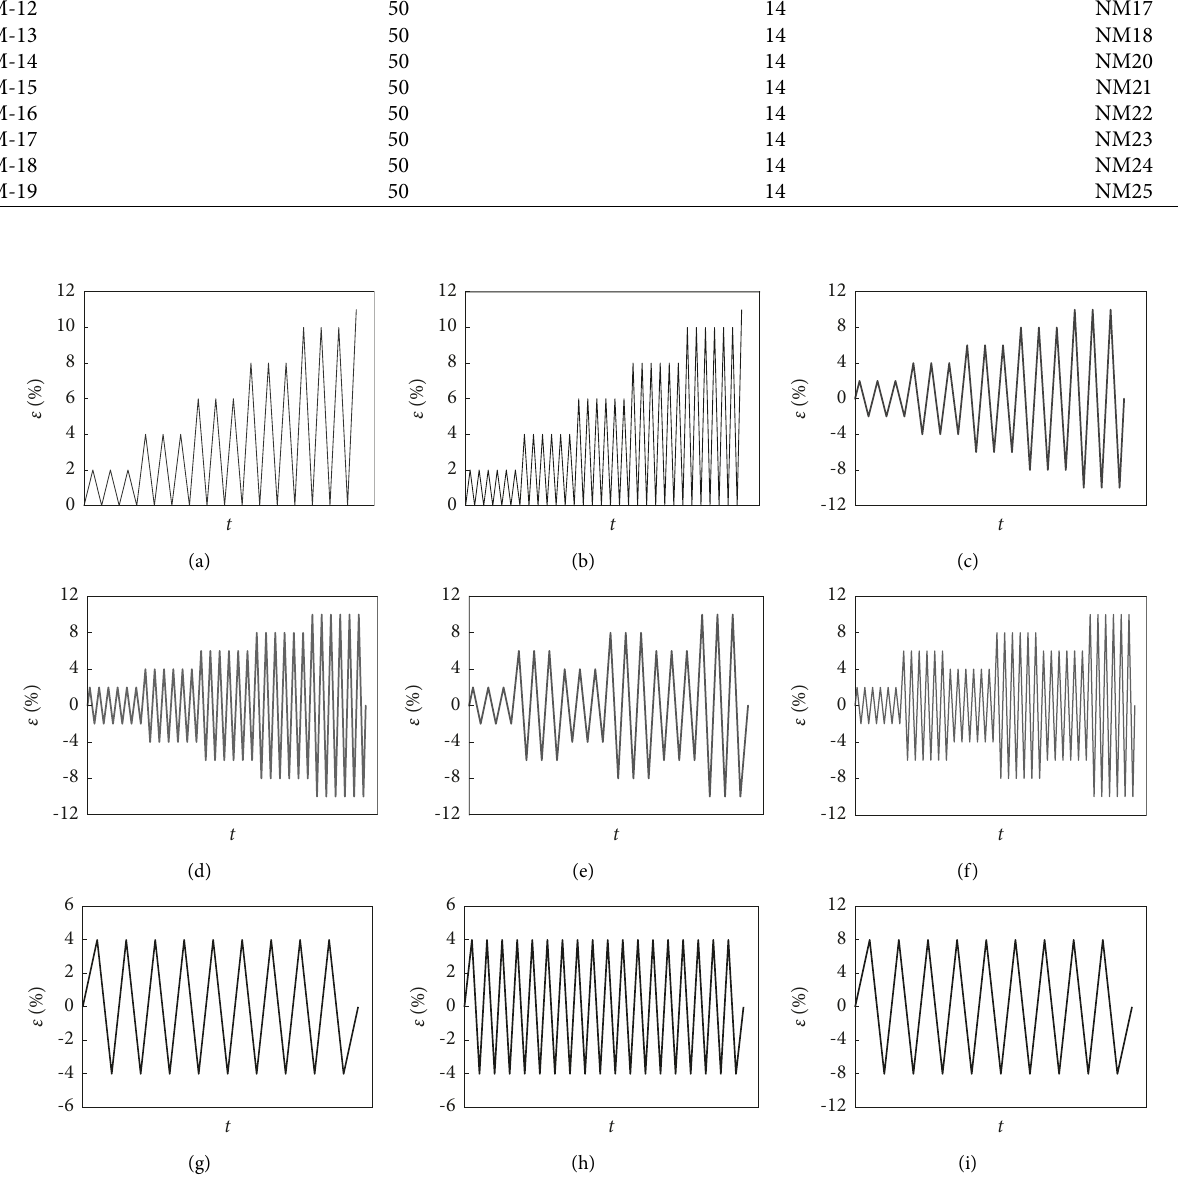
Figure 15: Loading patterns of the numerical simulation specimens (s). (a) Loading pattern NM17. (b) Loading pattern NM18. (c) Loading pattern NM19. (d) Loading pattern NM20. (e) Loading pattern NM21. (f) Loading pattern NM22. (g) Loading pattern NM23. (h) Loading pattern NM24. (i) Loading pattern